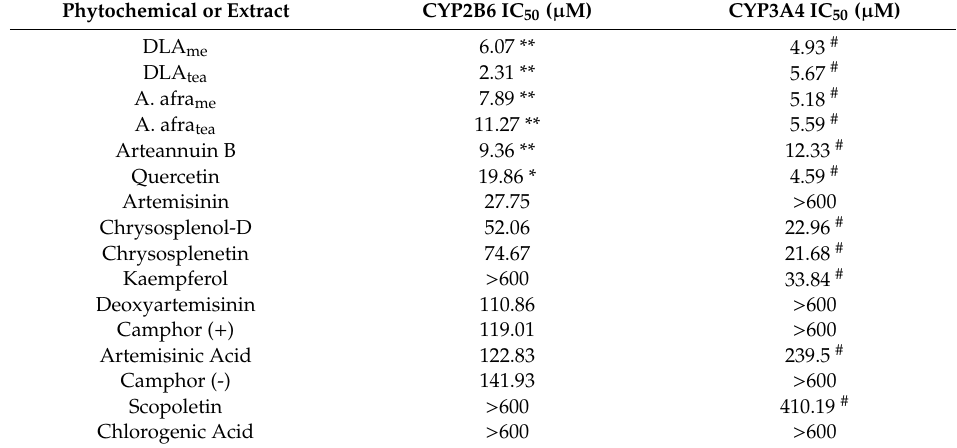
Table 1. Inhibition of CYP2B6 and CYP3A4 by DLA extracts, teas and phytochemicals.